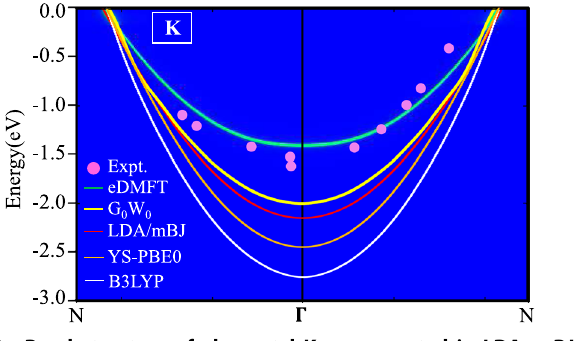
Fig. 2 Band structure of elemental K as computed in LDA, mBJ, G 0 W 0 , YS-PBE0, B3LYP, and eDMFT. Pink dots indicate angle- resolved-photoemission(ARPES) data from ref. 23 .